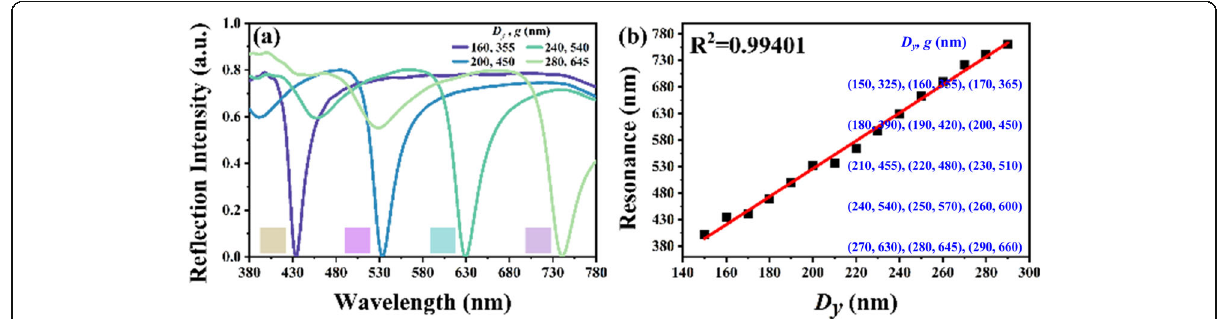
Fig. 2 a Reflection spectra of TAM with different D y and g values. b The relationship of resonances and D y